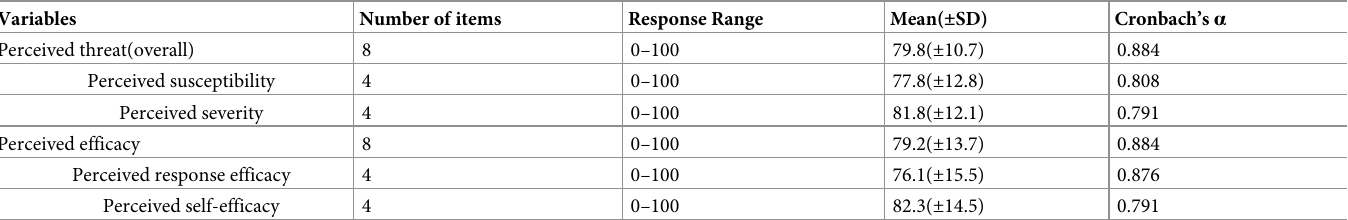
Table 3. Respondents mean, standard deviation and reliability scores of constructs of the extended parallel process model in Jimma University medical center, Ethi- opia April 12-May 25 2020 (n = 343).